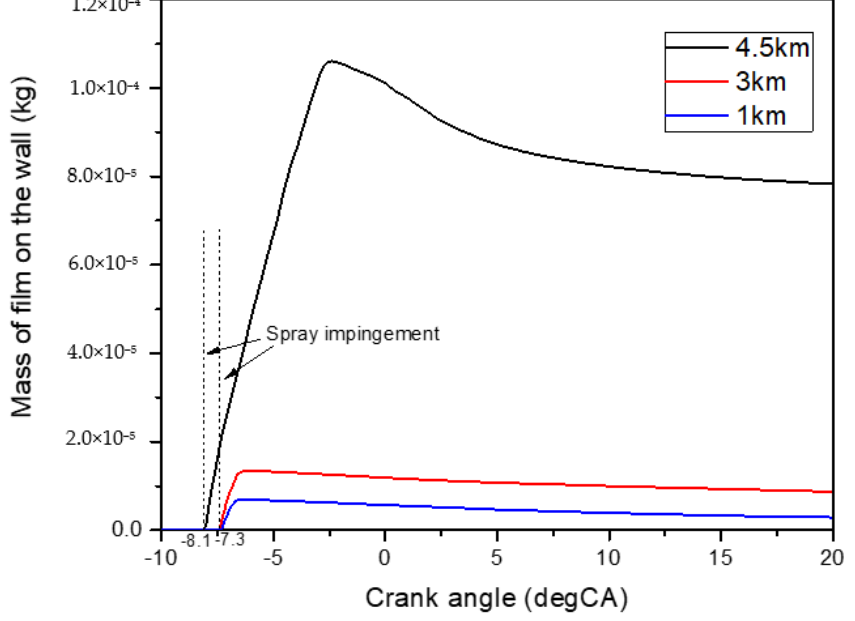
Figure 17. Mass of film on the wall at various altitudes.